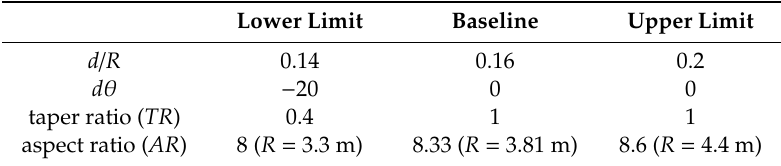
Table 3. Constraint conditions of design